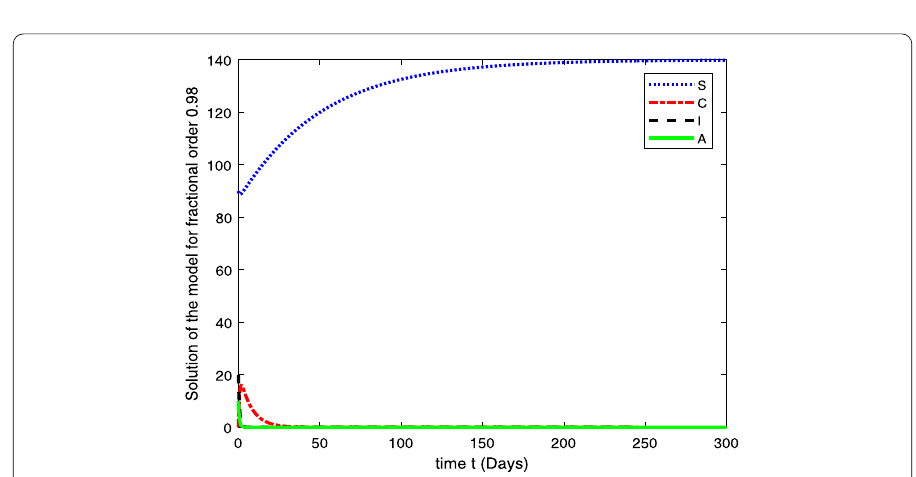
Figure 6 The solution for (1) for S , I , C , A , keeping h = 0.1 and α = 0.98